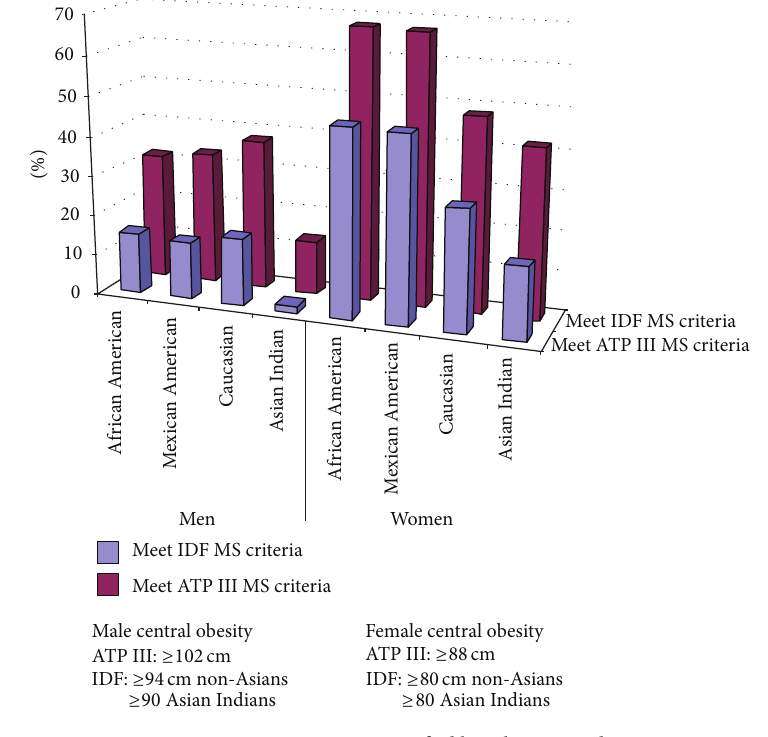
Figure 2: Waist categories stratified by ethnicity and sex.